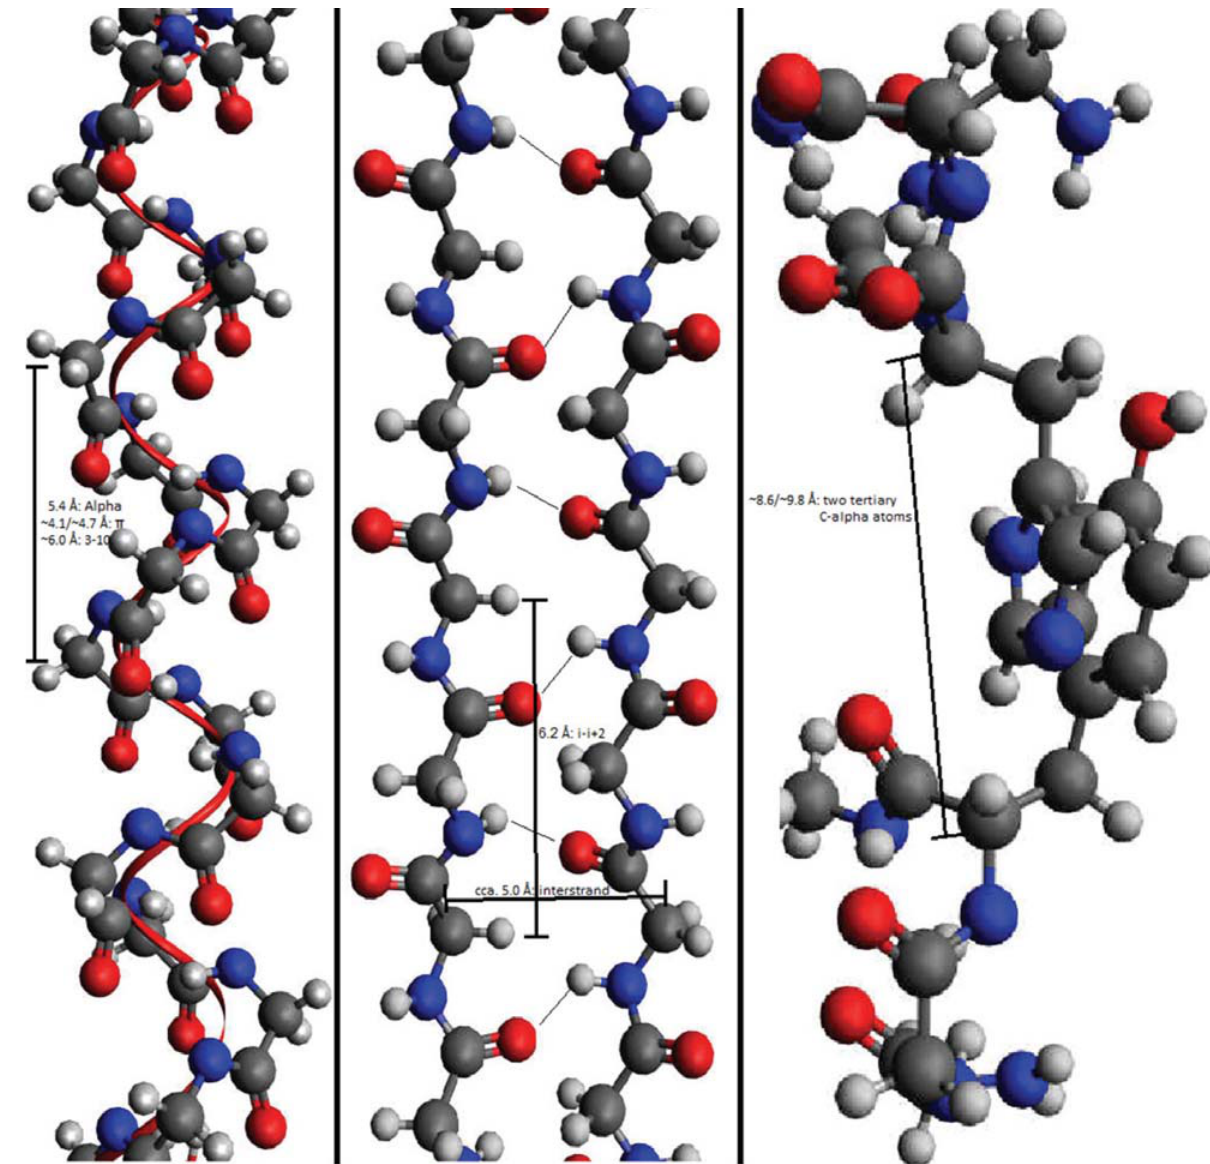
Figure1 : Left – a polyglycine helical peptide with the distance between two C-alpha atoms likely responsible for , alpha and 3–10 peaks at around 4.1–4.7 Å, 5.4 Å, and 6.0 Å in our results, respectively, marked by a black line. Note that the molecular structure shown is actually an alpha helix – the other two helices have a bit different shape, besides a different pitch length. Middle – two polyglycine beta strands forming an antiparallel beta sheet, with hydrogen bonds marked by interrupted thin black lines. The horizontal black line highlights an example of an interstrand C-alpha-C-alp- ha distance likely responsible for peaks at around 5.1 Å. The vertical black line marks an example of an intrastrand i-i+2 C-alpha-C-alpha distance likely responsible for peaks at around 6.2 Å. Right – an example of two peptides related by a tertiary interaction between an imidazole group and a p-hydroxyphenyl group of a histidine and a tyrosine residue, respectively. It is an example of our structural interpretations for peaks at around 8.6 Å and 9.8 Å. The black line shows the distance between C-alpha atoms of the two